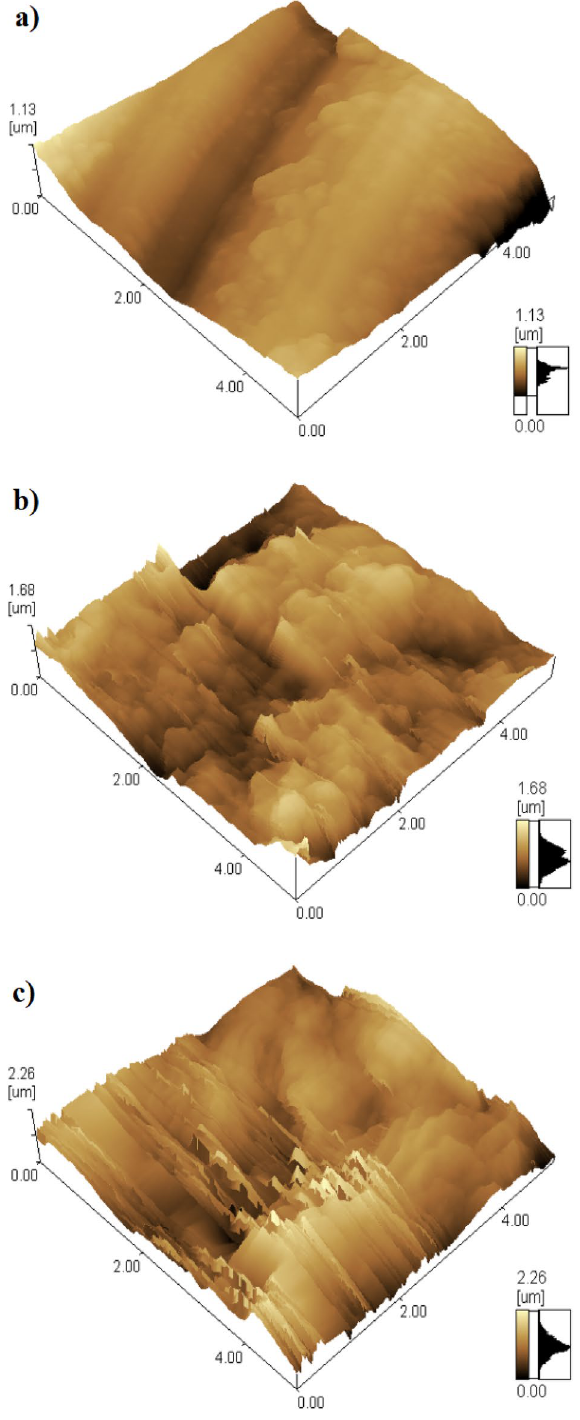
Figure 6. 3D AFM topography images of the surface of ( a ) bare and SHP coated steel with ( b ) Ni@G@MA and ( c )